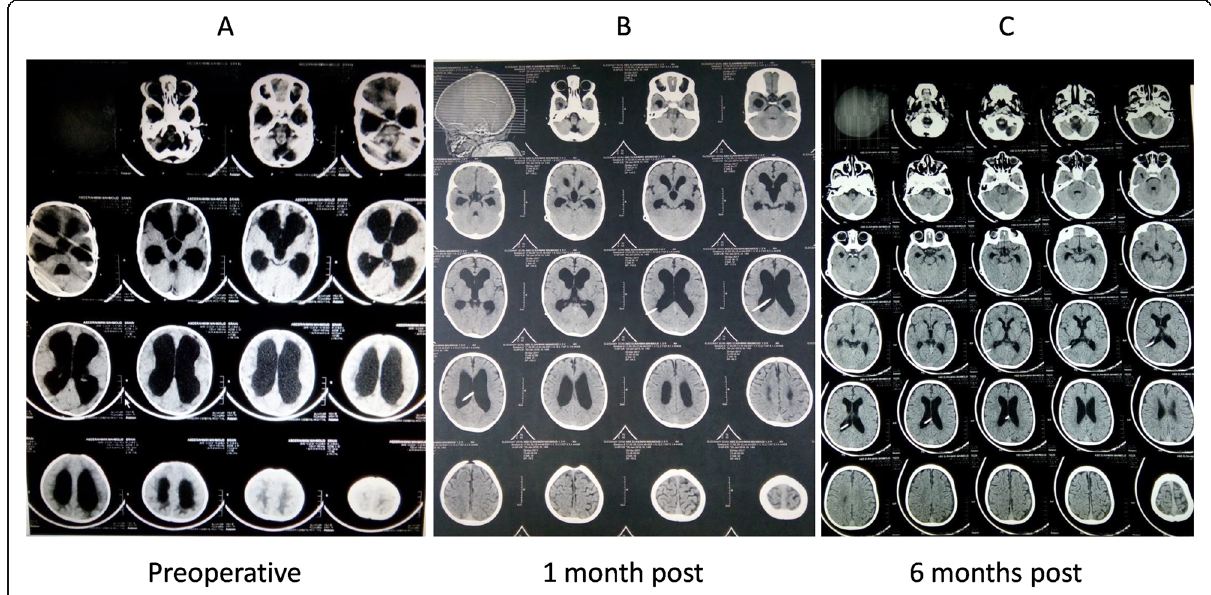
Fig. 2 A CT brain of hydrocepahic child. a Preoperative, b 1 month postoperative, and c 6 months